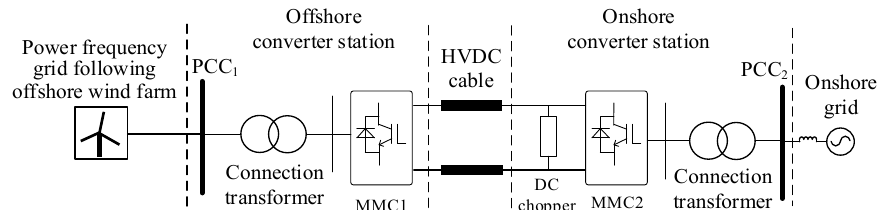
Figure 4. Scheme 3-HVDC transmission scheme for power frequency grid-following offshore wind farms.